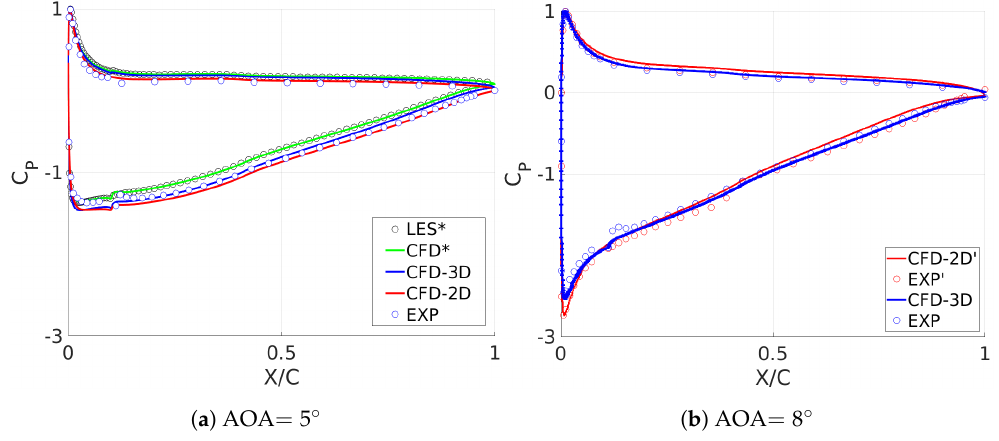
Figure 3. Chordwise C p distribution: LES, CFD, and EXP. The airfoil is tripped, except for cases marked with prime symbol in the legend. The airfoil is in the wind tunnel except for cases marked with ‘*’, which are in free-flight (unconfined) condition. Further details are found in [8,9].